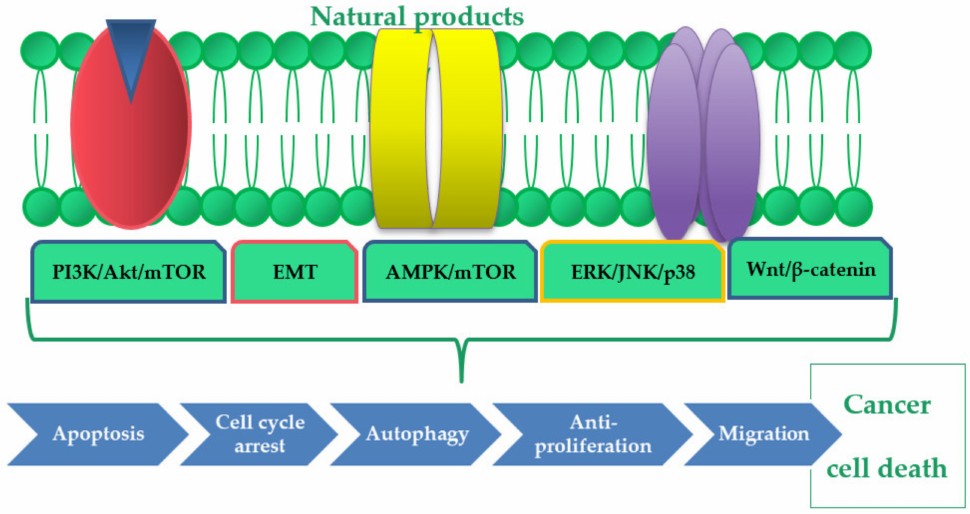
Figure 1. The molecular e ff ects of natural products in gastric cancer